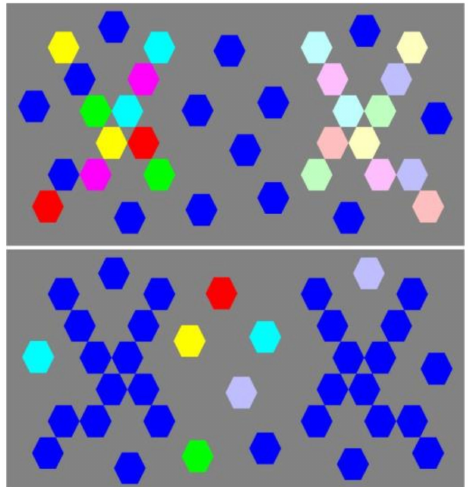
Figure 6. When additional noise is added, the saliency of any bilateral symmetry pattern will be more or less severely